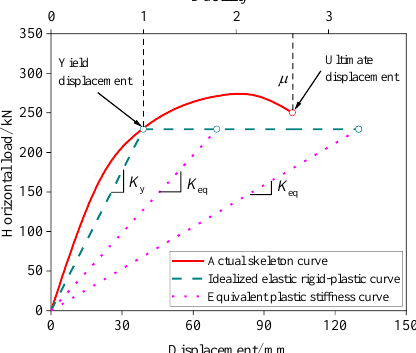
Figure 14. Idealized elastic rigid-plastic curve.